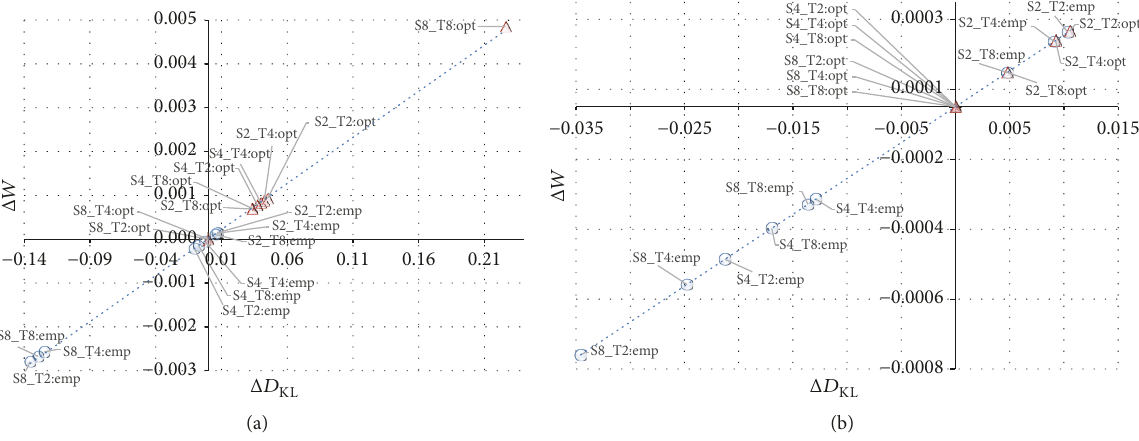
𝑒,𝑔 𝑊 ∝ Δ𝐷 . For the cases of (a) Japanese exports KL